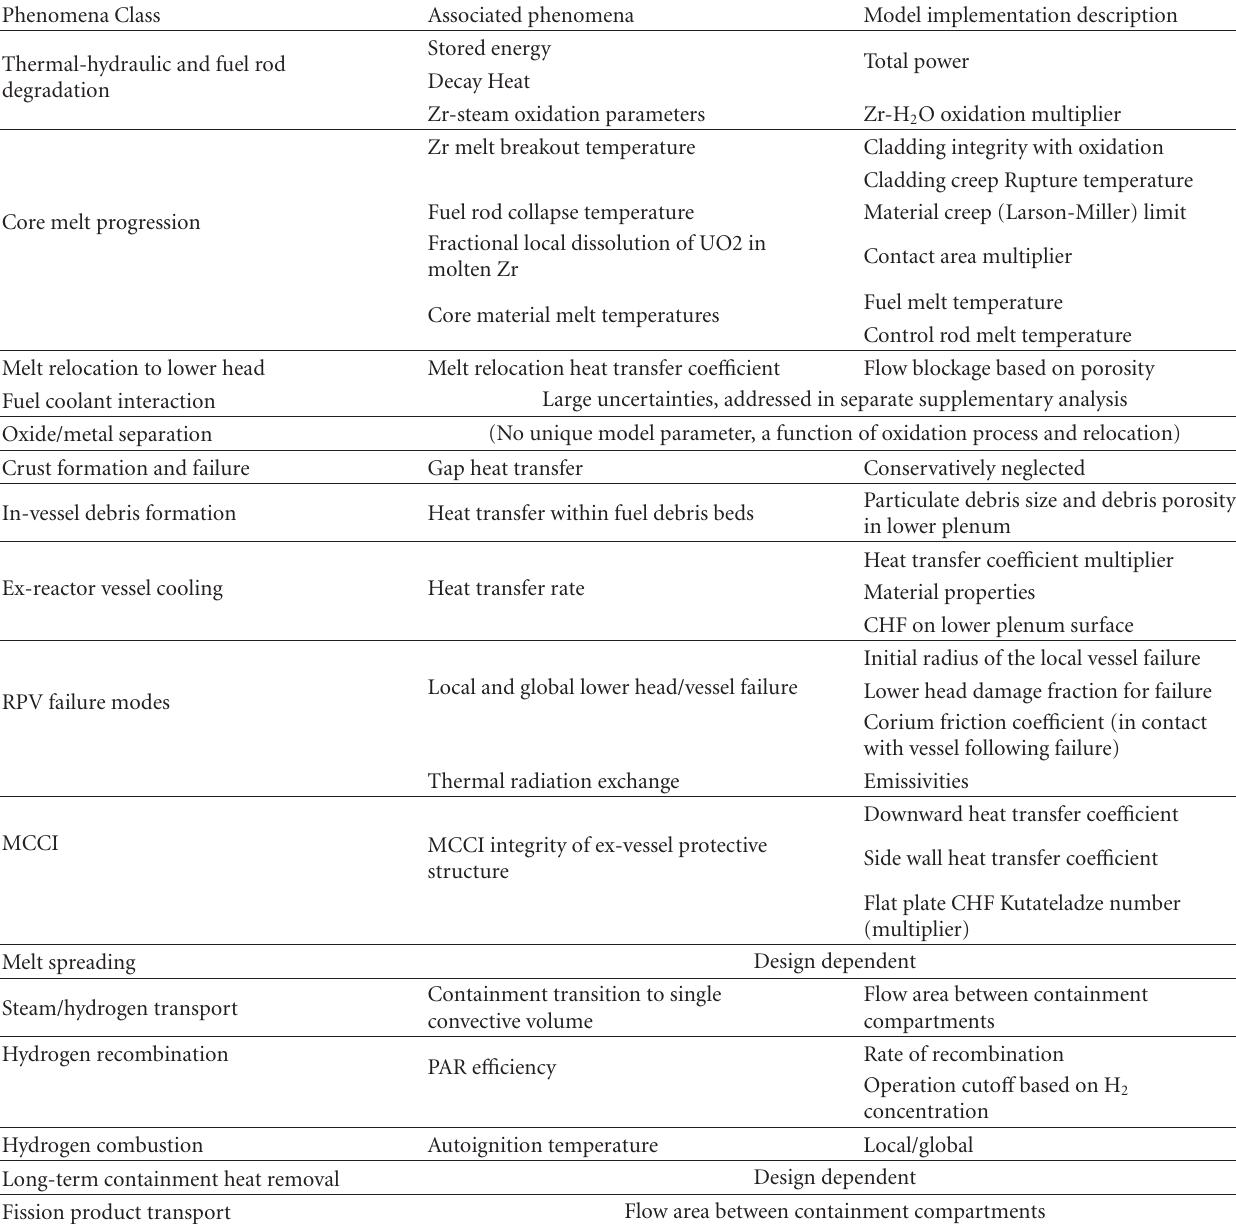
Table 5: Sample mapping of identified phenomena to code model